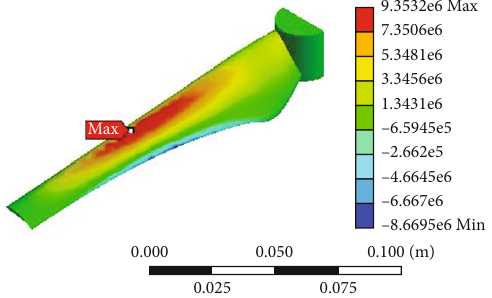
Figure 10: Total stress distribution.